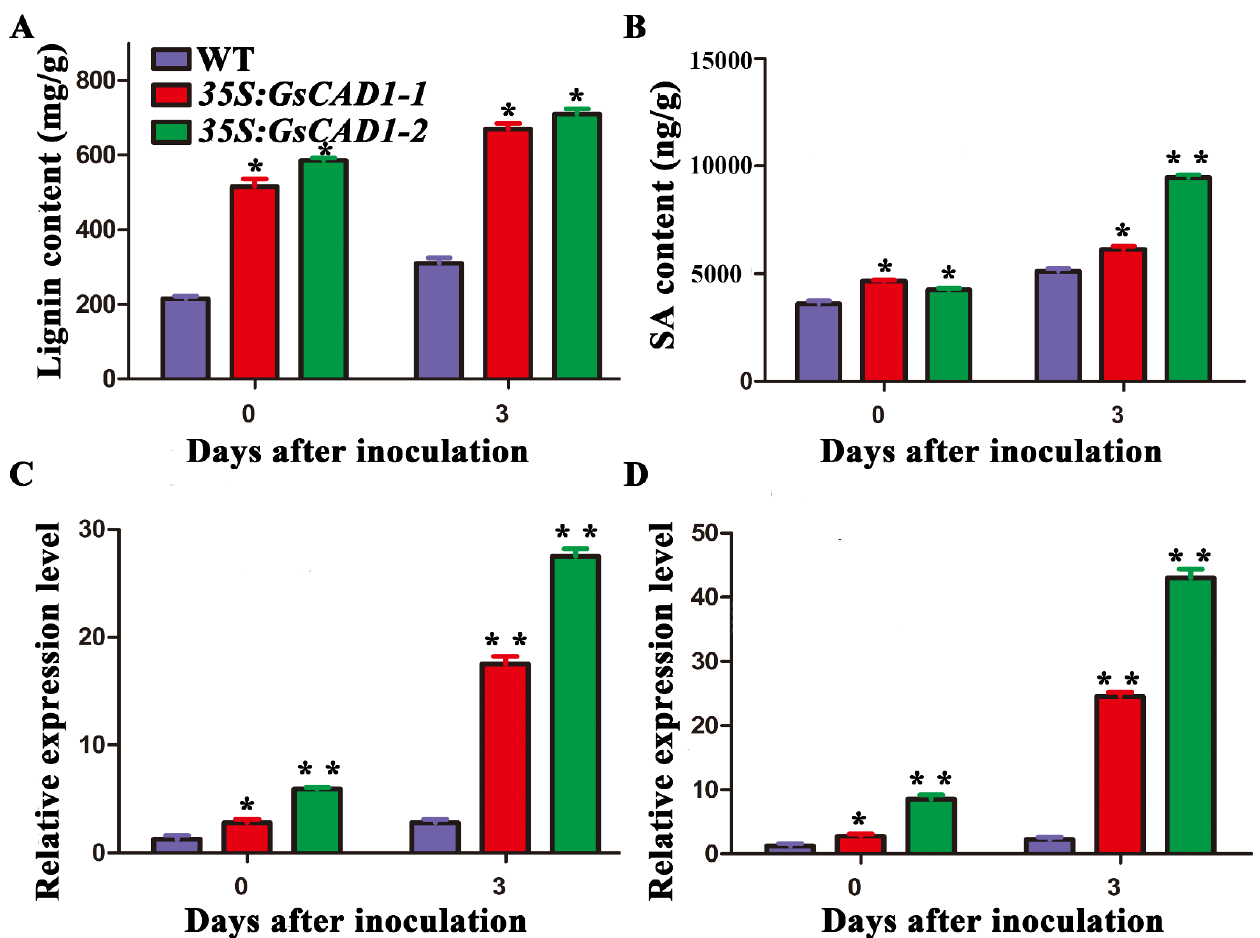
Figure 3. Increased lignin and SA content and expression levels of related genes in GsCAD1 - overexpression transgenic soybean lines before and after SMV inoculation. ( A ) Changes of lignin content between the wild-type and 35S:GsCAD1 transgenic plants before and 3 days after inoculation with SMV, respectively. At 14 days, the wild-type and 35S:GsCAD1 transgenic plants were inoculated with virus. The inoculated leaflets were collected immediately before inoculation (0 h) and 3 days after the SMV inoculation. The asterisks in each panel represent significant content and/or expression differences between WT and OE lines (Student’s t -test, *, p < 0.05). ( B ) SA contents in the wild-type and 35S:GsCAD1 transgenic plants. At 14 days, the wild-type and 35S:GsCAD1 transgenic plants were inoculated with virus. The inoculated leaflets were collected immediately before inoculation (0 h) and 3 days after the SMV inoculation. Endogenous SA was measured by HPLC. Data represent the mean ± SD of three replicates. The asterisks in each panel represent significant content and/or expression differences between WT and OE lines (*, p < 0.05, **, p < 0.01). ( C ) Expression of SA synthetic gene PAL-03g in the wild-type and 35S:GsCAD1 transgenic plants before inoculation (0 h) and 3 days after the SMV inoculation. Data represent the mean ± SD of three independent experiments at 35 days of SMV inoculation, with each experiment consisting of three technical replicates. * Significantly different from that in the wild-type (*, p < 0.05, **, p < 0.01). ( D ) Expression of SA-responsive gene PR1 in the wild-type and 35S:GsCAD1 transgenic plants before inoculation (0 h) and 3 days after the SMV inoculation. Data represent the mean ± SD of three independent experiments at 35 days of SMV inoculation, with each experiment consisting of three technical replicates. The asterisks in each panel represent significant content and/or expression differences between WT and OE lines (*, p < 0.05; **, p <